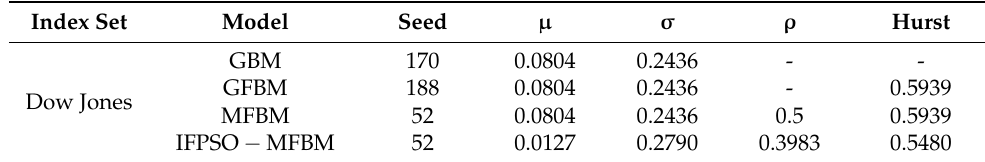
Table 11. Parameters of the Dow Jones in the four